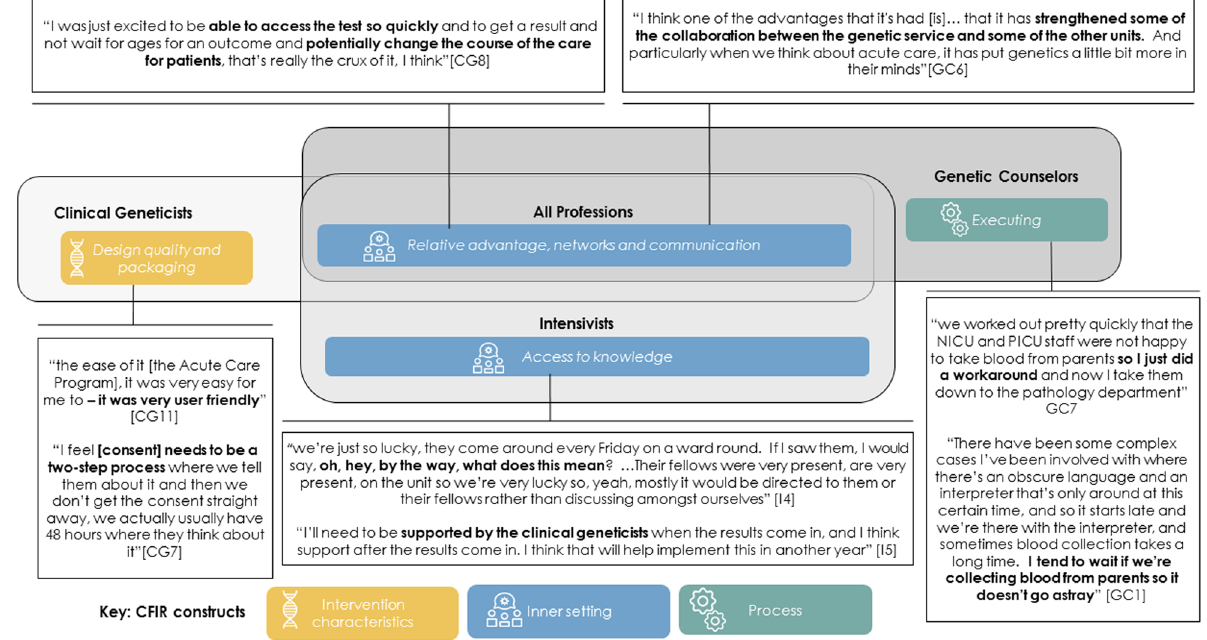
Fig. 3 Differences by profession for fi ndings by Consolidated Framework for Implementation Research (CFIR) domains and constructs, with exemplar quotes. Three CFIR domains (with their associated constructs) are reported: intervention characteristics (design quality and packaging), inner setting (access to knowledge, relative advantage, networks and communications) and process